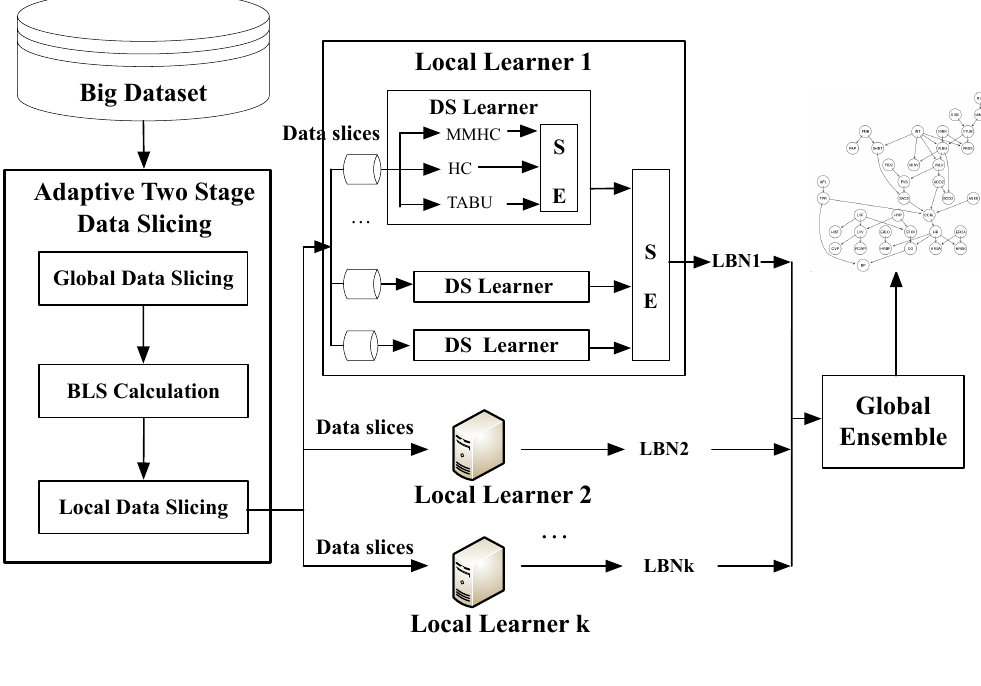
Figure 2. An Overview of PEnBayes